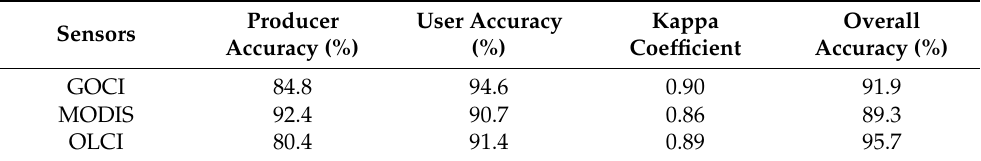
Table 4. Threshold values for each type of object accuracy evaluation of classification